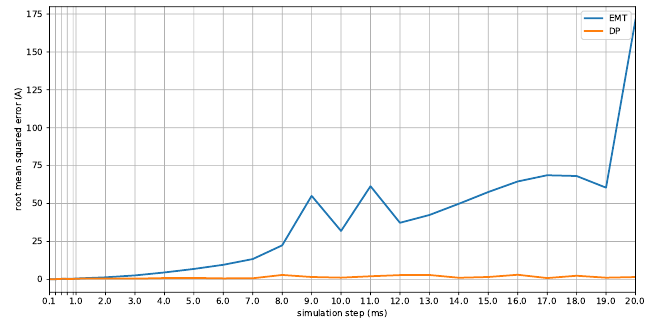
Figure 10. RMSE of EMT and DP simulation results with respect to the reference